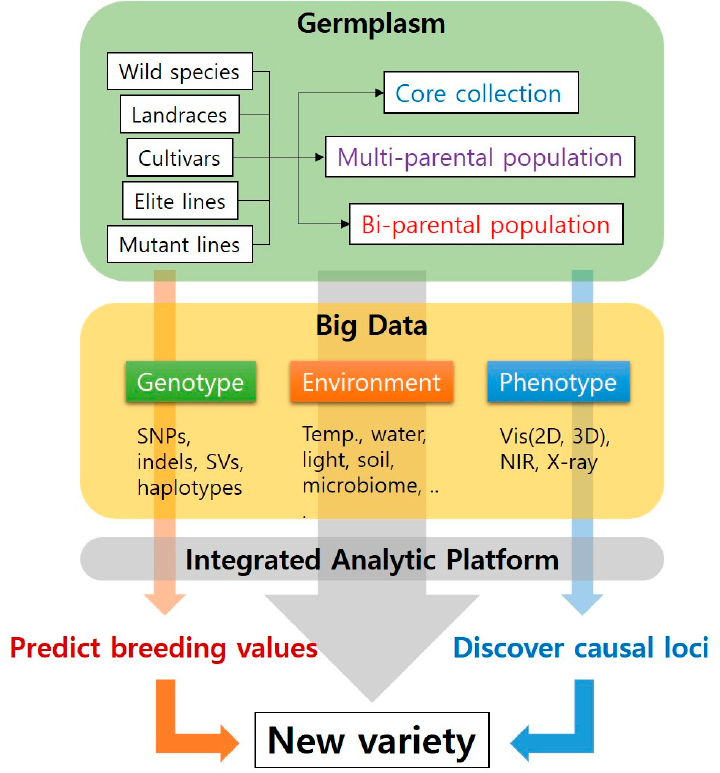
Figure 4. Flowchart of plant breeding in the era of genomics big data.